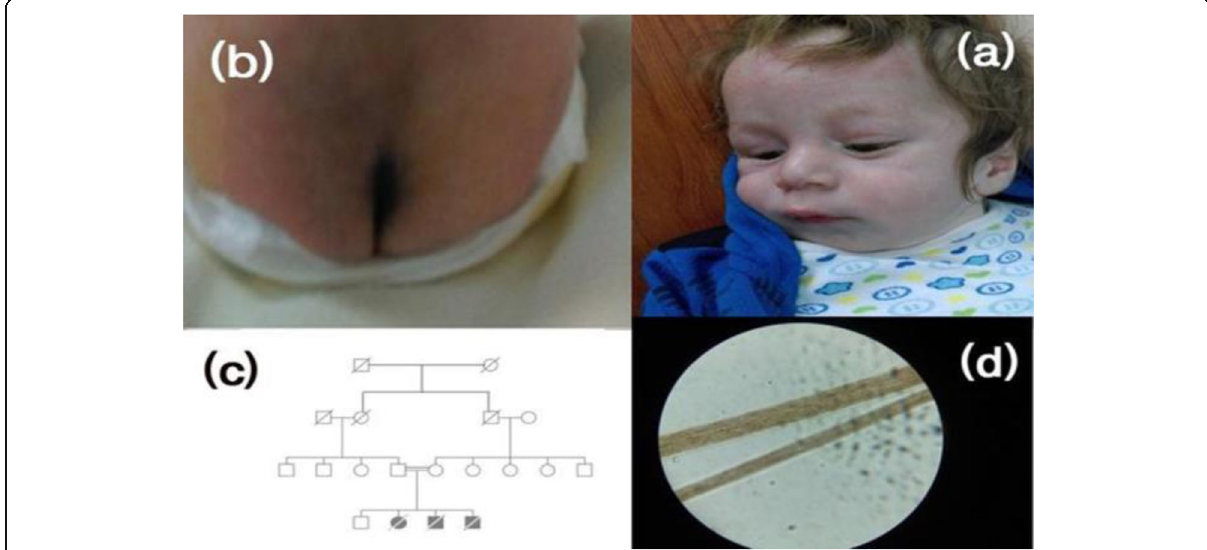
Fig. 1 a The phenotype of the index case shows hypopigmented hair and skin, b tuft of hair on the index patient ’ s lower back over the sacral region, c the family pedigree, and d hair trichogram showing an absent medulla and a decrease in